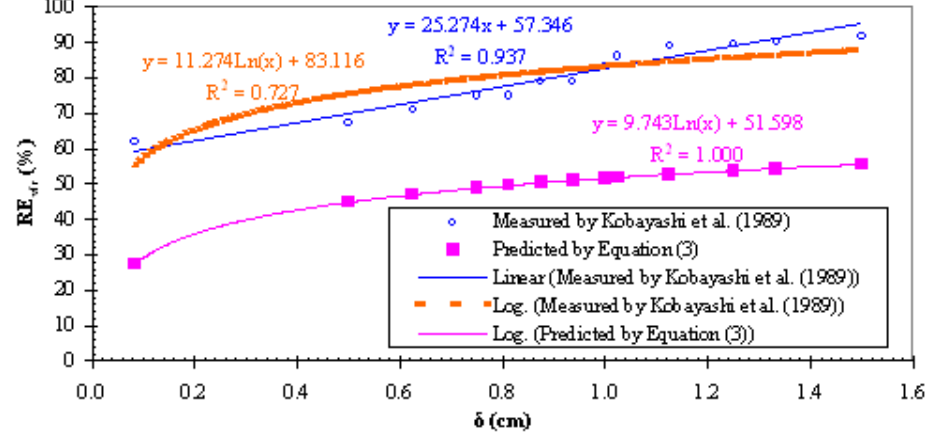
Figure 4. Measured and predicted relative vapor flow resistance (VFR) effect (RE vfr in Equation (3)) versus thickness ( δ ) of the dry soil layer (DSL) for a 5-cm-long repacked columm of the Japanese Tottori dune sand soil (after